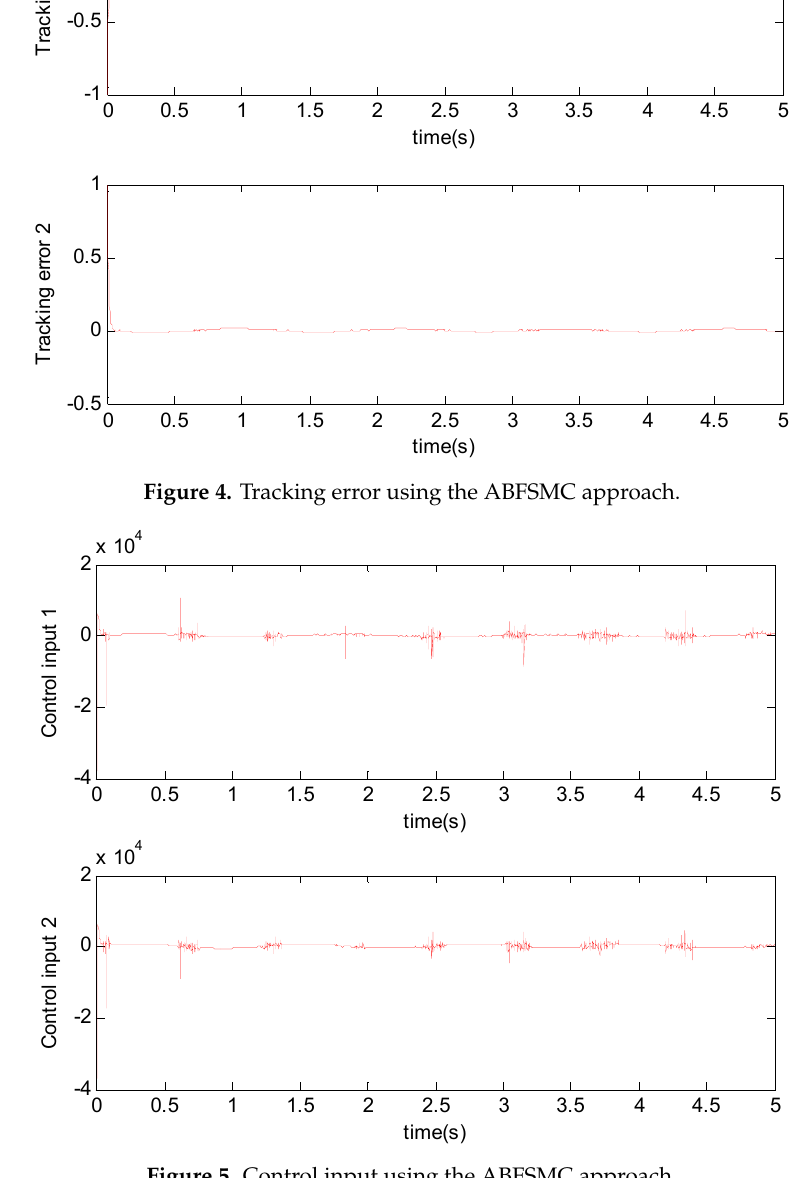
Figure 5. Control input using the ABFSMC approach.